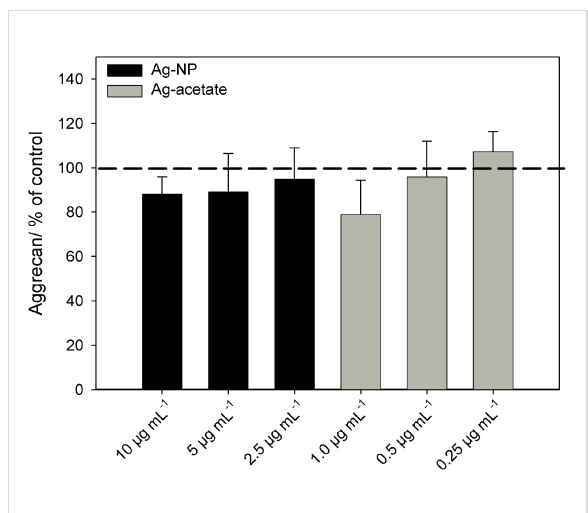
Figure 10: Release of the chondrogenic differentiation marker aggrecan after incubation of hMSCs with Ag-NP/Ag + ions. The data are expressed as the mean ± SD ( n = 7 independent experiments), given as the percentage of the control (aggrecan 5 ± 1.9 ng·mL − 1 ; cells cultured without silver, dashed